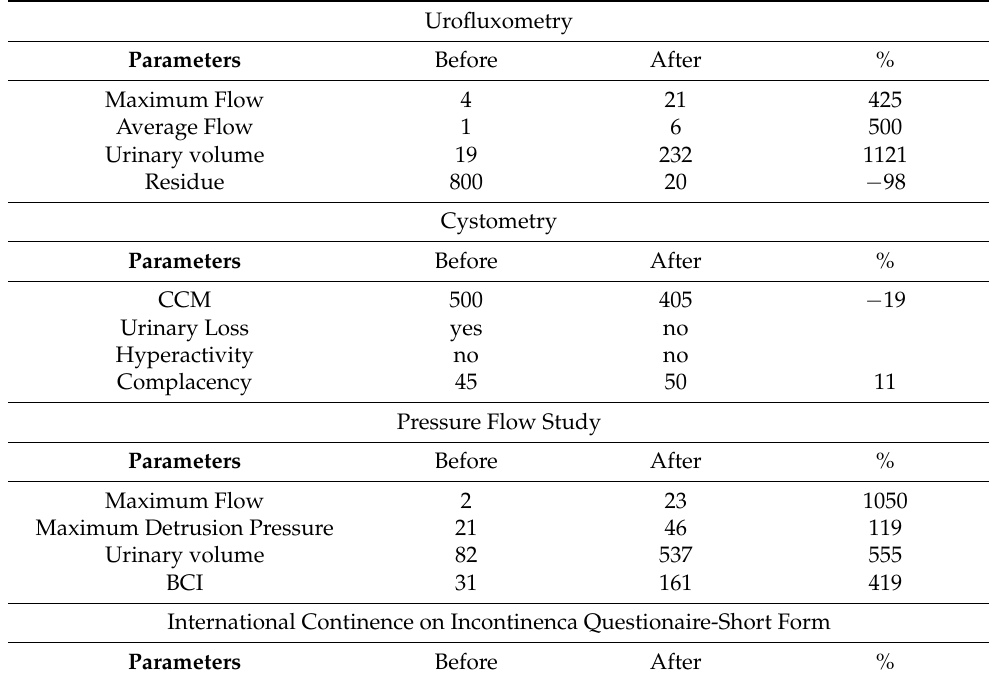
Table 1. Absolute values and percentage variation of the results of urofluxometry, cystometry and study of pressure flow and score of the International Continence on Incontinence Questionaire-Short Form, before and after cell